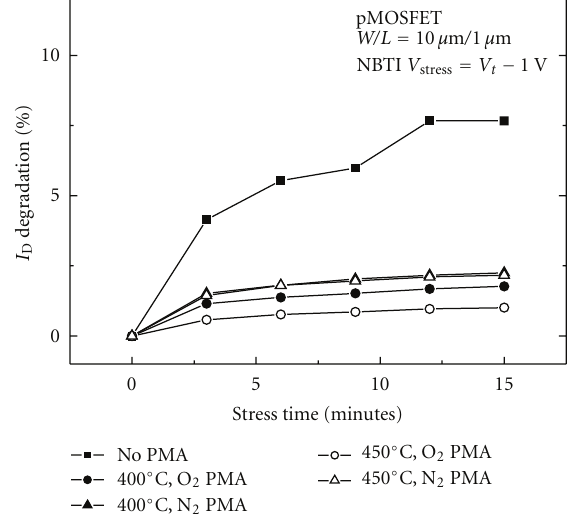
Figure 6: The extracted I D degradation after constant voltage stress.